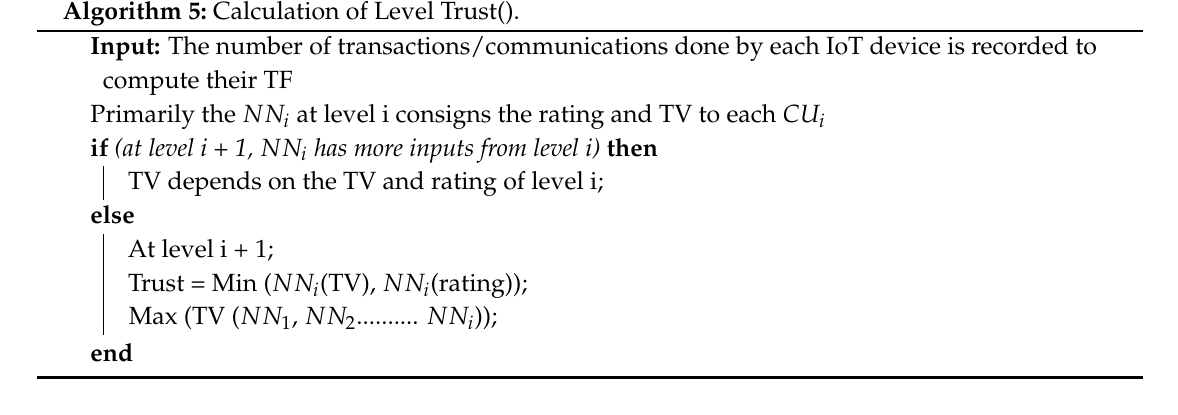
Algorithm 6: Calculation of